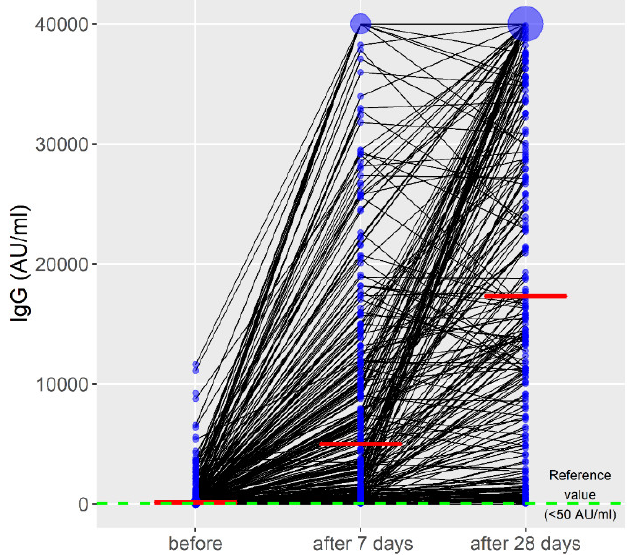
Figure 1. Titers of anti-spike immunoglobulin G during the observed period. The red line represents the median IgG values; the blue circle represents the number of cases with the same IgG values.